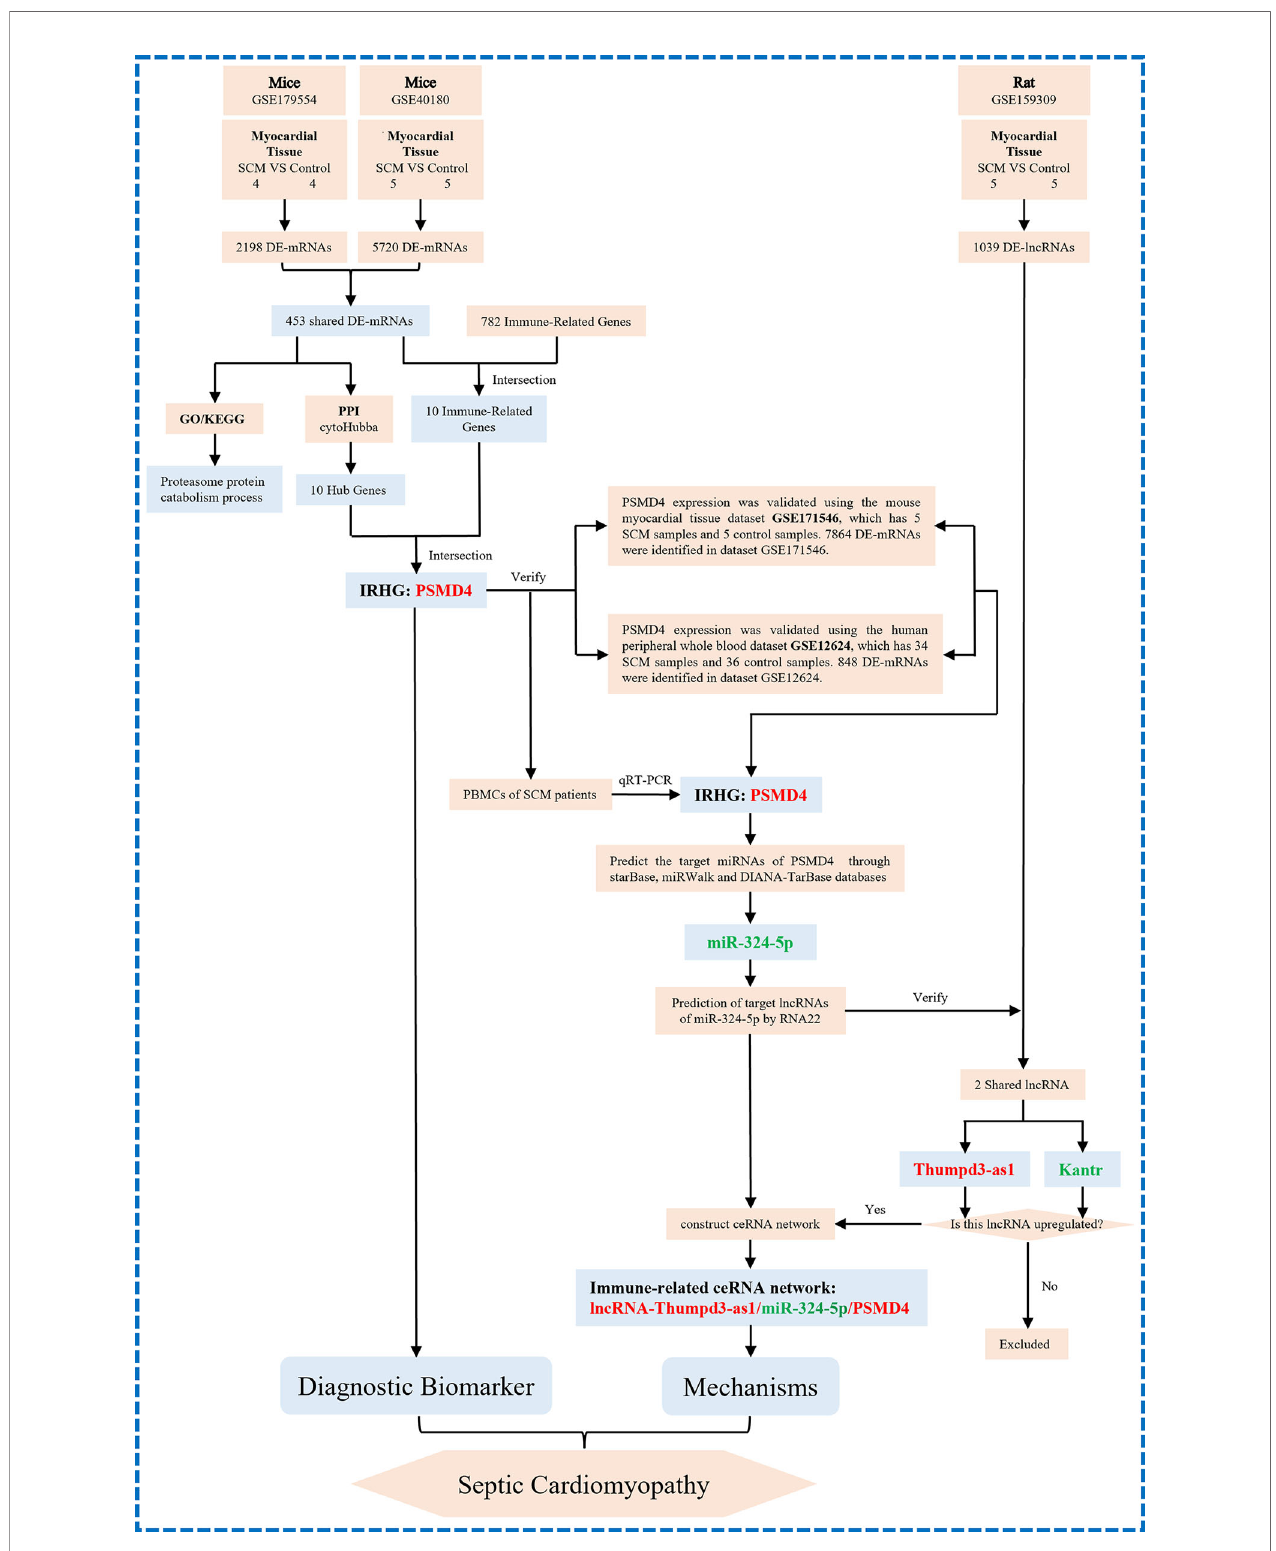
FIGURE 8 | The technical work fl ow of this article and we proposed the novel ceRNA network. The red word means upregulation, and the green word means downregulation. IRHGs, immune-related hub genes.